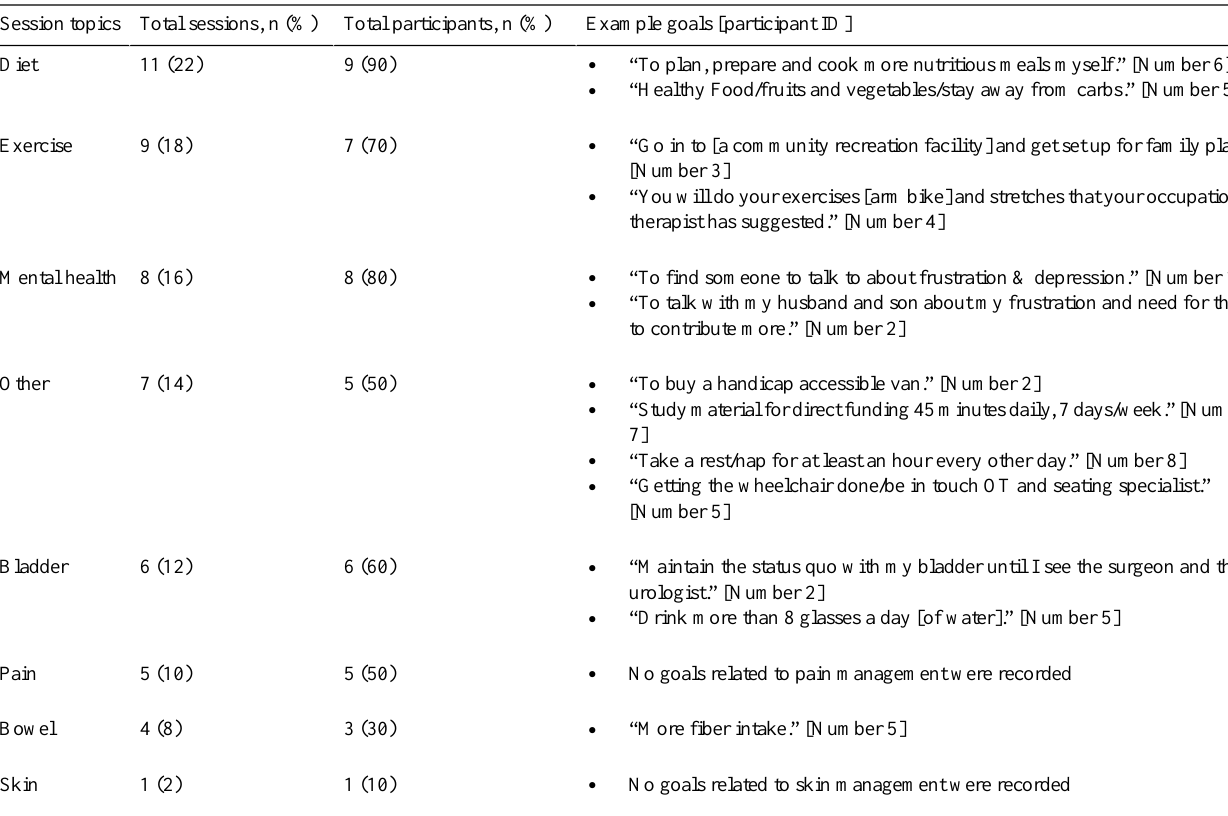
Table 2. Health management topics chosen by participants for coaching sessions and related